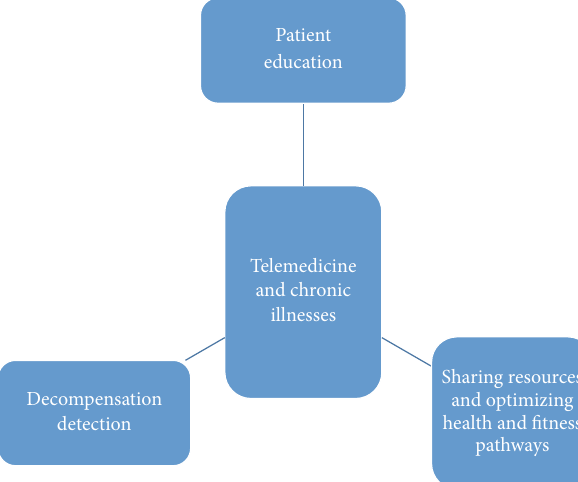
Figure 1: Telemedicine and chronic